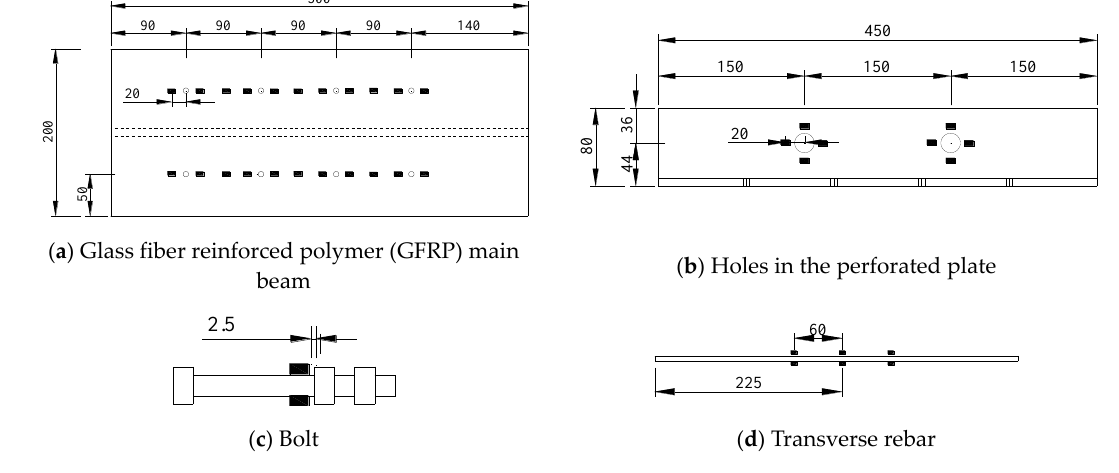
Figure 5. Strain measurement points. (units: mm)